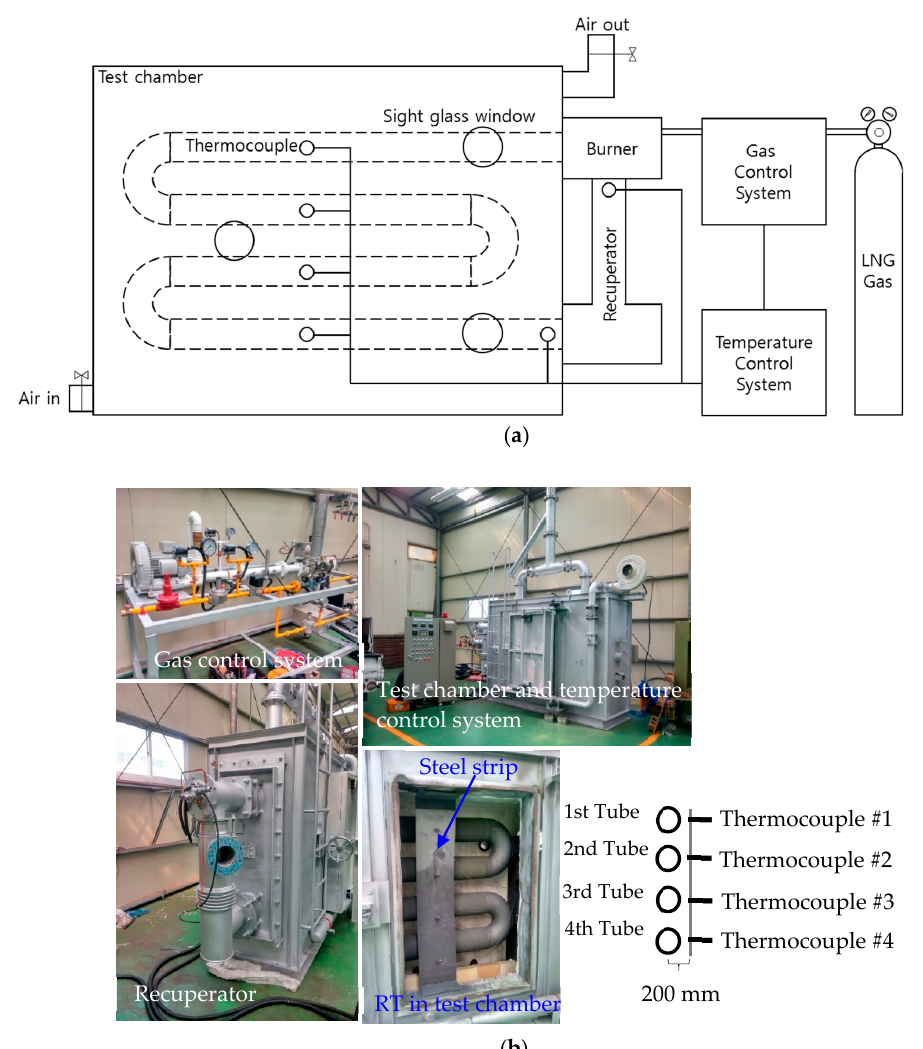
Figure 9. ( a ) Schematic of the pilot furnace that evaluates radiant heat efficiency of full-size RTs with and without honeycomb patterns. ( b ) Description of each component in the pilot furnace.